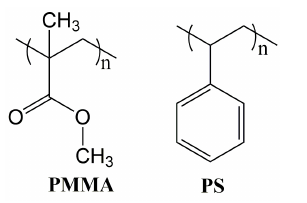
Figure 10. Chemical structure of PMMA and PS.